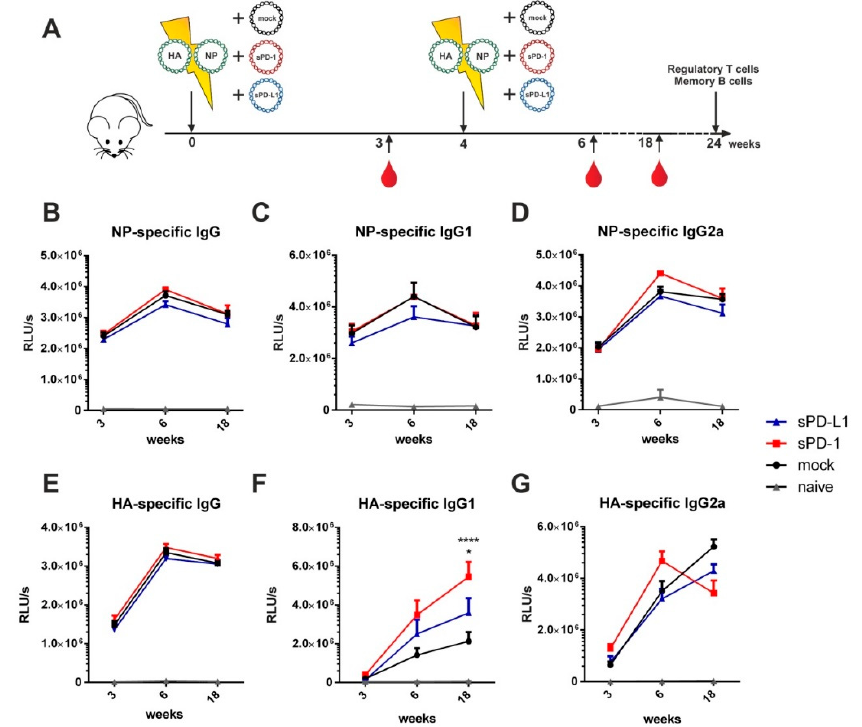
Figure 3. Soluble checkpoint co-expression modulates HA-specific antibody responses. ( A ) Six-week old BALB/c mice were electroporated intramuscularly with expression plasmids encoding for HA and NP together either with an empty vector (mock) or plasmids encoding for sPD-1 or sPD-L1. Four weeks after priming, a booster immunization was administered Blood was drawn at weeks 3, 6 and 18 and antibody responses were analyzed by ELISA. NP-specific IgG ( B ), IgG1 ( C ) and IgG2a ( D ) antibody responses and HA-specific IgG ( E ), IgG1 ( F ) and IgG2a ( G ) antibody responses in the sera of BALB/c mice after i.m. electroporation over a time-period of 18 weeks. Shown are mean values with SEM ( n = 9–18) and significant differences between immunized groups (two-way ANOVA analyses followed by Tukey’s multiple comparison test, ( F ) * p < 0.05 for sPD-L1 group compared to sPD-1 group, **** p < 0.0001 for sPD-1 group compared to mock).